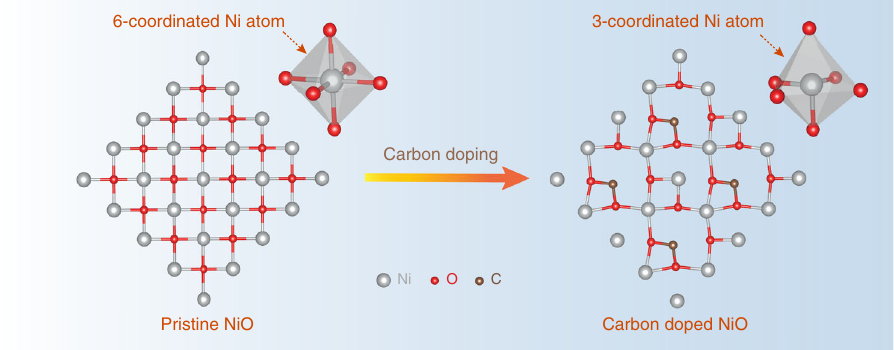
Fig. 1 DFT calculated structure of pristine NiO and carbon doped NiO DFT calculations showing the carbon doping induced structure change of NiO (the color coding for different atoms is consistent for the whole